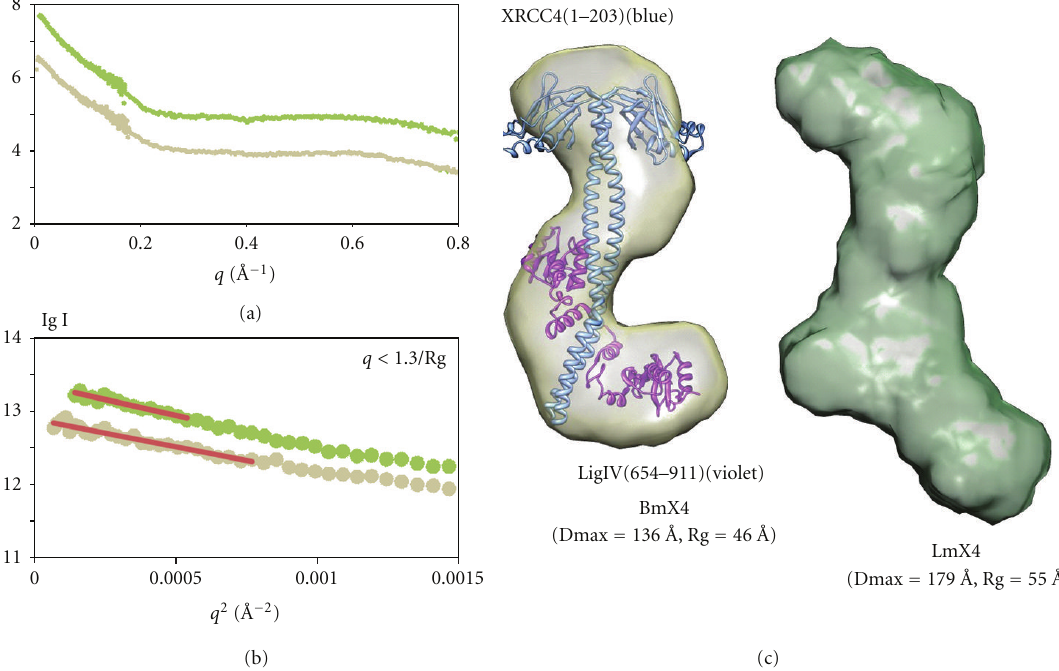
Figure 14: SAXS study of LmX4 and Bm4. (a) SAXS data of LmX4 (green) and BmX4 (gold) where q = (4 π sin θ ) /λ . (b) Guinier plots of LmX4 and BmX4 with liner fits (red line) q < 1 . 3 / Rg. (c) Shape reconstructions of BmX4 (gold) and LmX4 (green) created by using Dammin [130]. Ten individual models were calculated and averaged by Damaver [131]. NSD of BmX4 and LmX4 are 0.780 and 0.814, respectively. Molecular envelopes were produced using the UCSF Chimera package from the Resource for Biocomputing, Visualization, and Informatics at the University of California, San Francisco (supported by NIH P41 RR-01081) [132]. The crystallographic model of BmX4 (PDB code: 3II6) was superimposed into its molecular envelope by using